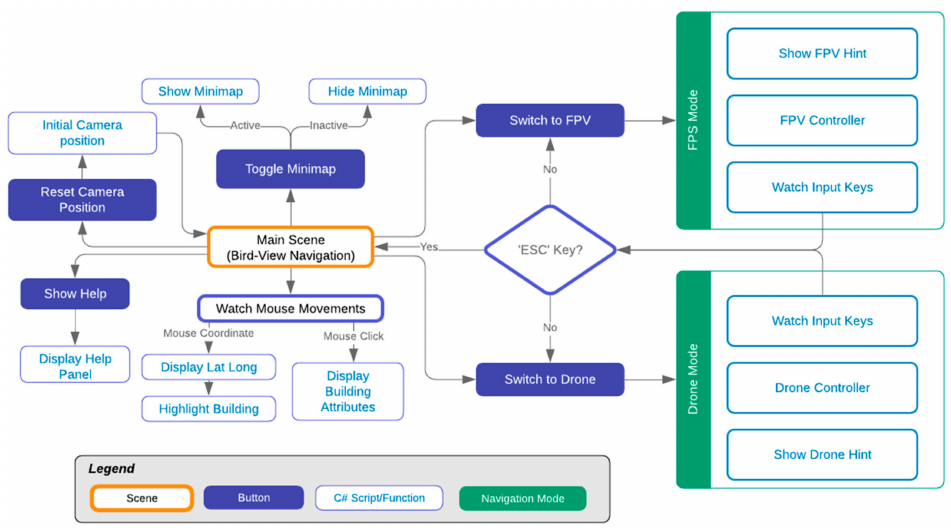
Figure 7. Logical flow of the application interface.